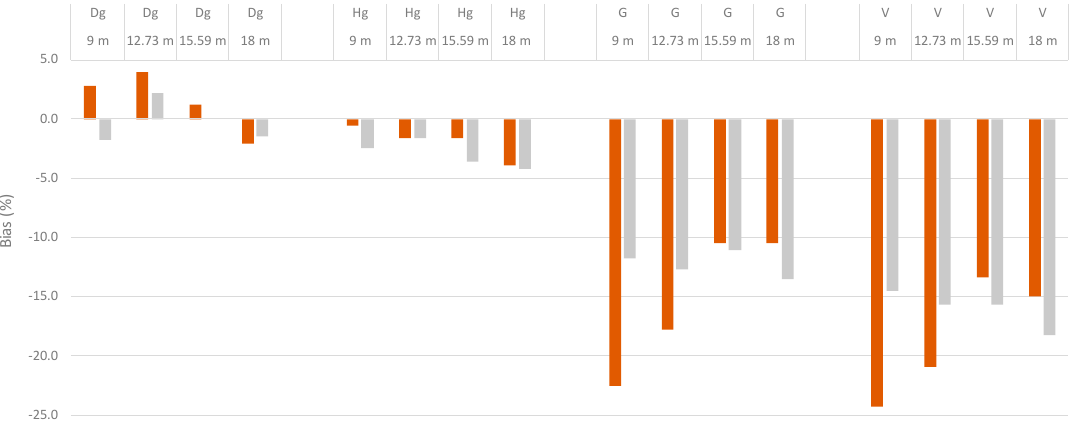
Figure 4. Bias of the stand level ( n = 150) predictions for D g , H g , G, and V. Predictions were made using two different single-tree positioning methods for deriving forest inventory attributes for sample plots (XY H , XY HH ) and with four different sample plot sizes. Note that sample plot size is given as the radius (in m) of the sample plot, not area (in m 2 ). See also data from Table 2.